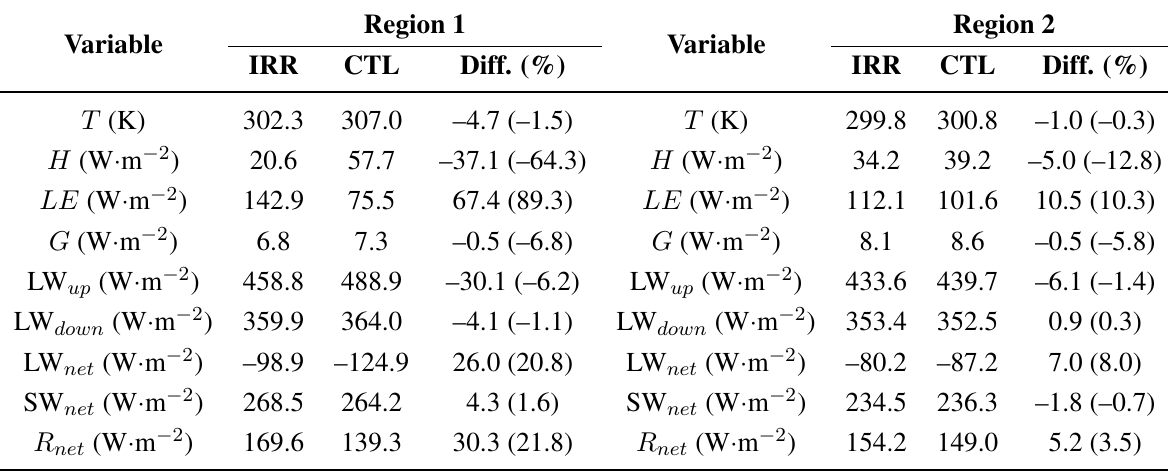
Comparison of elements of the surface energy balance, including radiative, turbulent, and ground fluxes, and temperature, for the two regions identified in Figure 1. Differences are presented as both absolute and percent change relative to the control